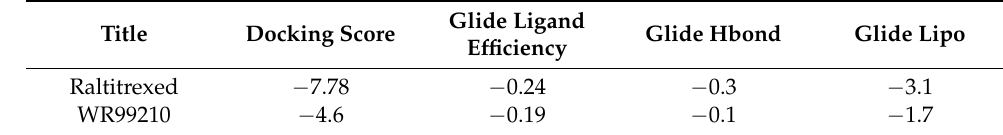
T. brucei dihydrofolate reductase.